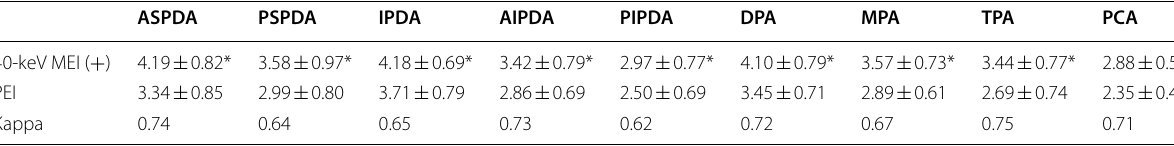
Table 2 Qualitative analysis